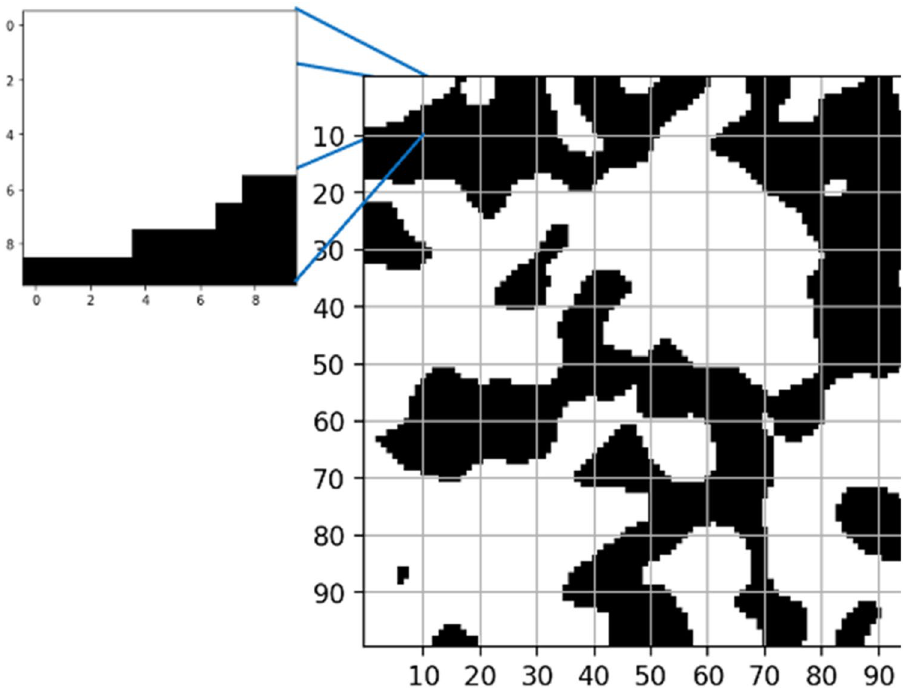
Figure 4. Sectioned regions of the entrance slice to analyze the possible inlet of the paths found within the domain. The inlet surface (100 × 100) has been divided into 10 × 10